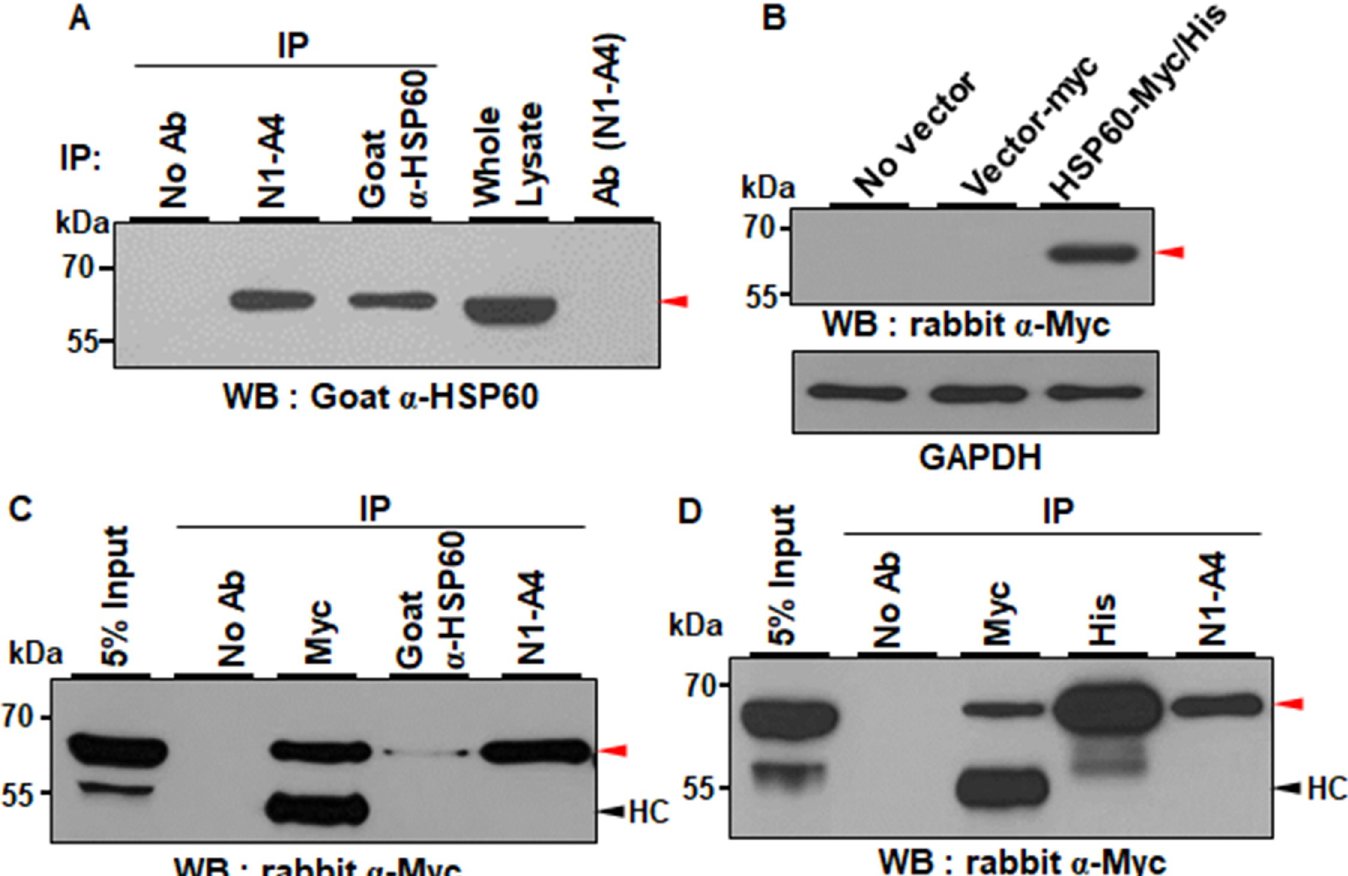
Fig 3. N1-A4 recognizes HSP60. (A) Huh7 cell lysates were immunoprecipitated with N1-A4 or goat anti-HSP60 antibodies ( α -HSP60), and the immunoprecipitates were detected with α -HSP60 in Western blot analysis. Red arrowhead indicates HSP60. (B) HSP60-Myc/His vector was overexpressed in 293FT cells, and Myc-tagged HSP60 protein was detected with α -Myc. β -actin expression was the loading control. (C, D) HEK293FT cells were transfected with HSP60-Myc/His expression vector. Cell lysates were immunoprecipitated with α -Myc, α -HSP60, and N1-A4 (C), or α -Myc, α -His, and N1-A4 (D). The immunoprecipitates were detected by Western blot analysis with α -Myc. Red arrowhead indicates the HSP60